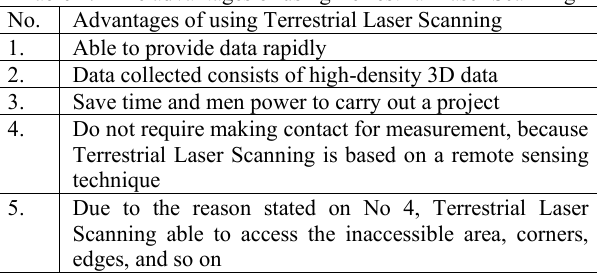
Table 1.1 The advantages of using Terrestrial Laser